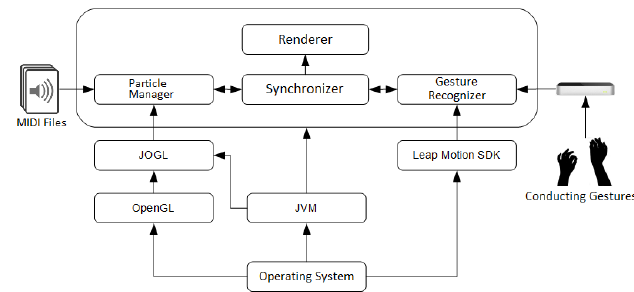
Fig. 10: System components.